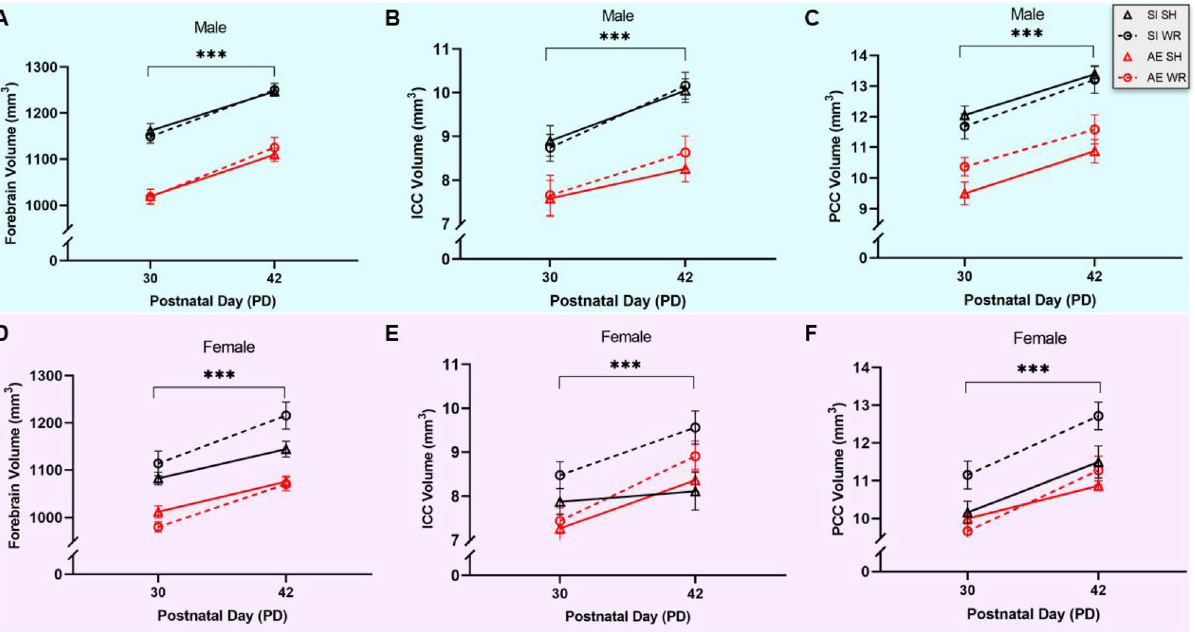
Figure 4. Average within-animal forebrain volume growth in male ( A ) and female ( D ) AE/SH, AE/WR, SI/SH, and SI/WR rats during the intervention period. Mixed repeated-measures ANOVA indicates that forebrain volume increases between PD30–42 in all rats (*** p < .001) and there is a significant interaction with intervention exposure. Average within-animal ICC volume growth in male ( B ) and female ( E ) AE/SH, AE/WR, SI/SH, and SI/WR rats during the intervention period. Mixed repeated-measures ANOVA indicates that ICC volume increases between PD30–42 in all rats (*** p < .001). Average within-animal PCC volume growth in male ( C ) and female ( F ) AE/SH, AE/WR, SI/SH, and SI/WR rats during the intervention period. Mixed repeated- measures ANOVA indicates that PCC volume increases between PD30–42 in all rats (*** p < .001). n = 7–12 rats per sex/postnatal treatment/intervention group. Error bars are mean ±